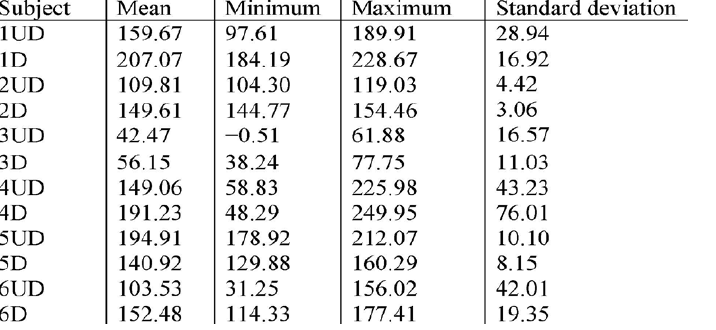
peak and C trough is indicated. 1 1